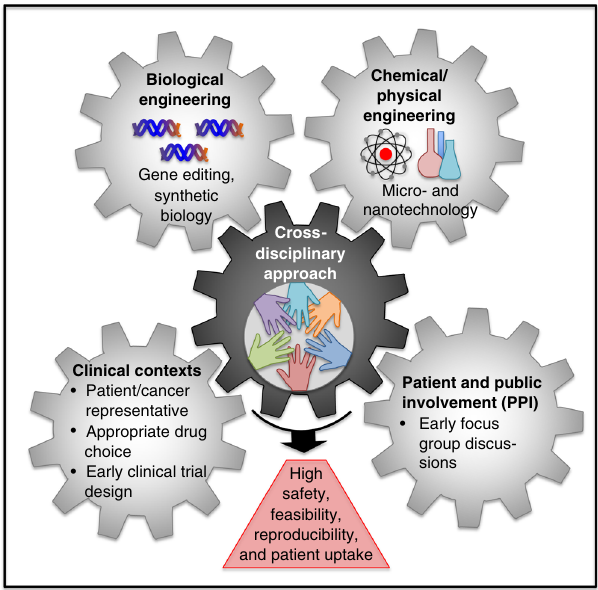
Fig. 8 Cross-disciplinary approaches required to maximise translatability and patient uptake of microrobotic drugs in the future. Interactions between basic scientists such as biological, chemical and physical engineers, as well as input from clinicians, patients and the public are critical for further developing microrobots as therapeutic and diagnostic anticancer